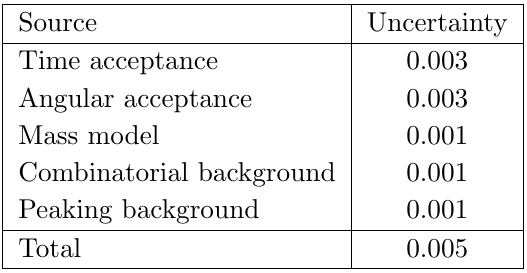
Table 6 . Summary of systematic uncertainties on A U and A V